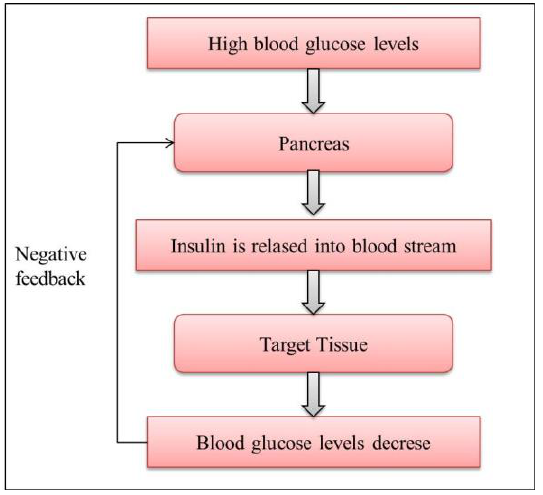
Figure 1. Regulation of blood glucose levels